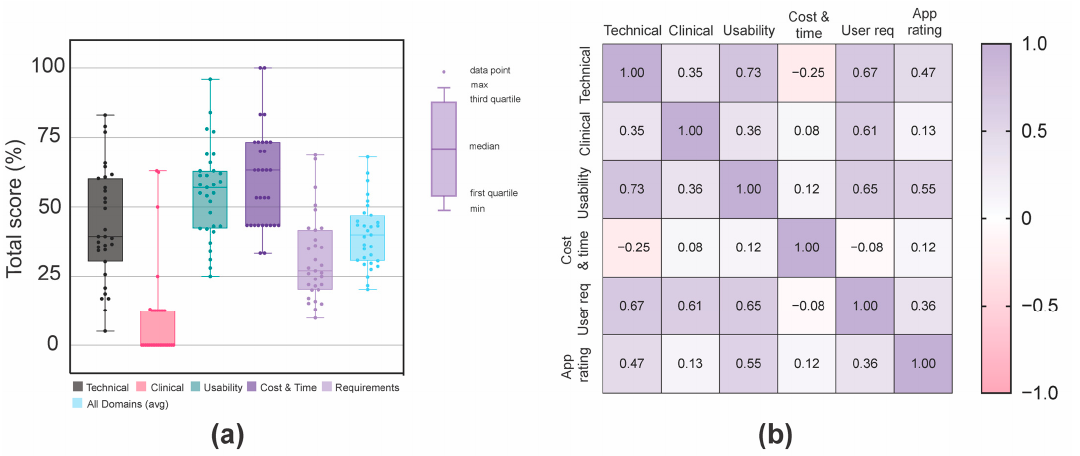
Figure 2. Pregnancy app performance by domain. ( a ) Individual domain scores for each pregnancy app. ( b ) Correlation matrix of each individual domain score and global app ratings. Pearson r values reported. Purple cells denote positive correlations and pink cells denote negative correlations.